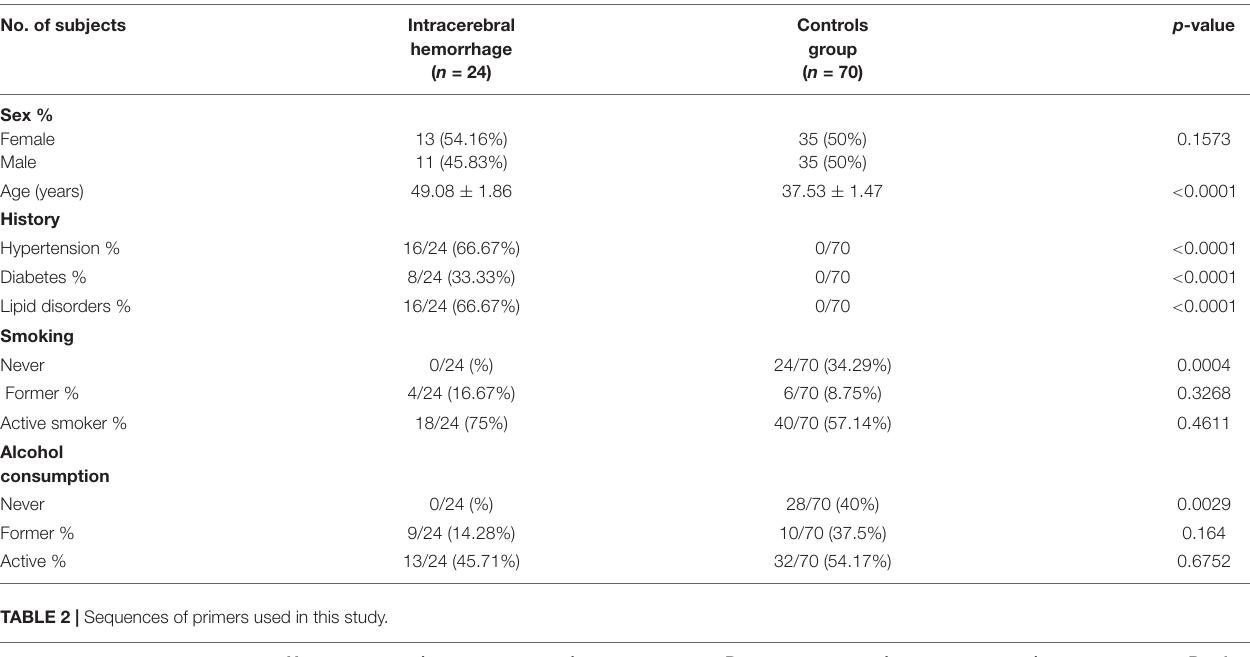
TABLE 1 | Clinical characteristics of study participants.